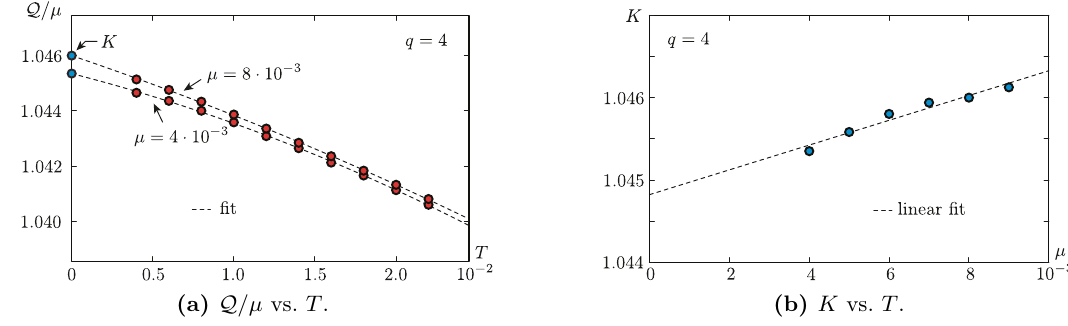
Figure 5. (a) Plot of Q =(cid:22) for di(cid:11)erent temperatures T and chemical potentials (cid:22) for q = 4. (b) Plot of K for di(cid:11)erent (cid:22)